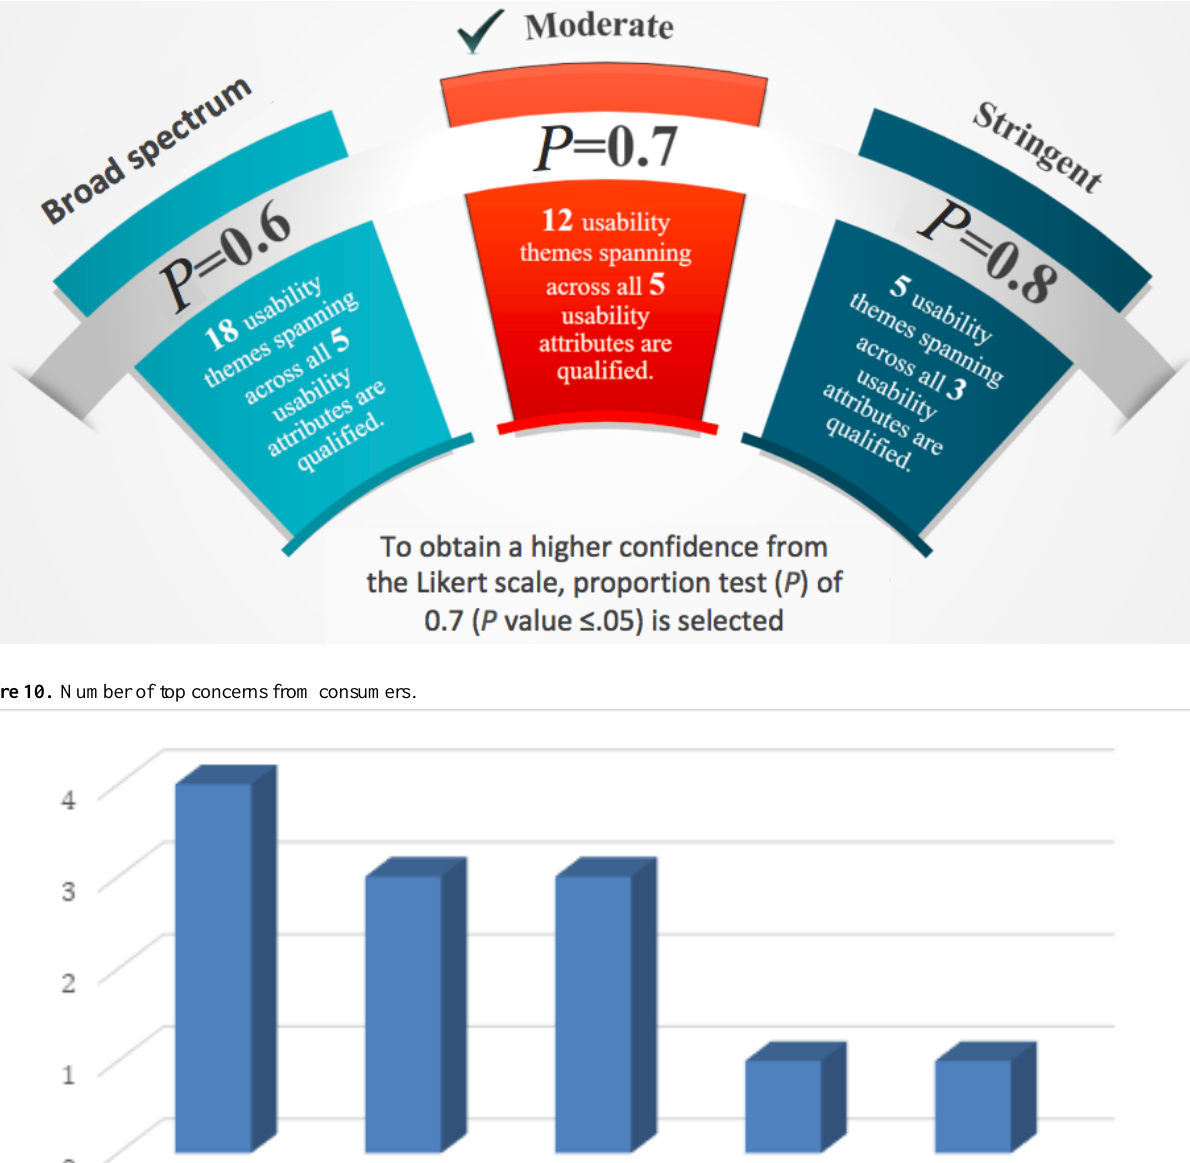
Figure 9. Sensitivity analysis for comparison of themes.